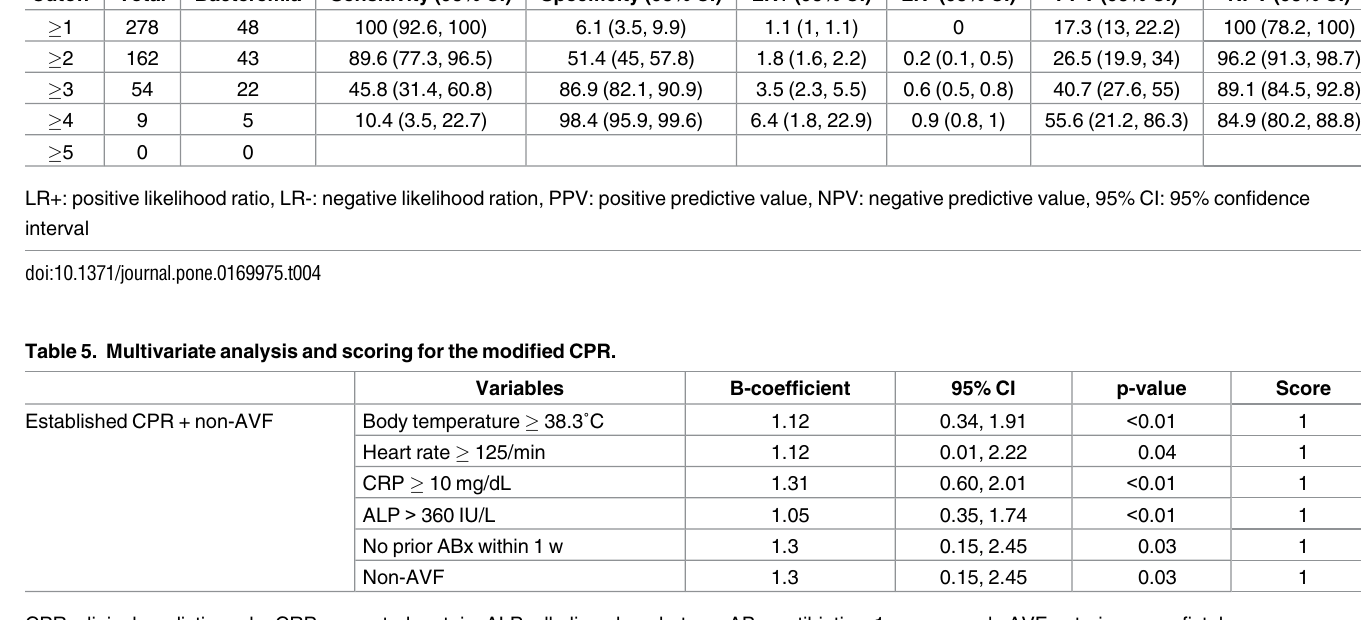
ration for possible cut-off scores in prediction rule are shown in Table 4. With a value of 2 set as the cut-off score in the CPR, the sensitivity was 89.6%, the specificity was 51.7%, the positive likelihood ratio was 1.8, the negative likelihood ratio was 0.2, and the percentage of false nega- tives was 3.8% (5/131). Next, as shown in Table 5, the modified CPR including non-AVF as the HD-specific pre- dictor was scored. The Hosmer-Lemeshow chi-squared statistic for the modified CPR was 2.12 (p = 0.71). The calibration slope and intercept of the CPR were 0.97 and -0.02, respectively.